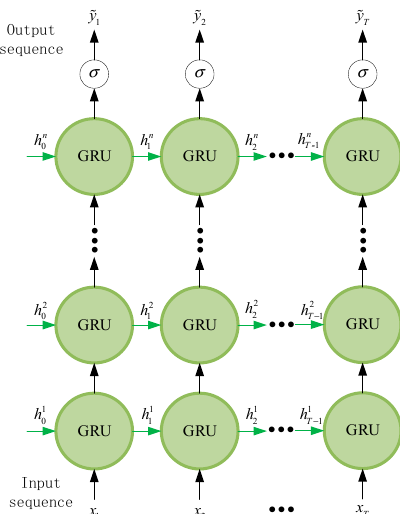
Figure 2. The structure of stacked-GRU.